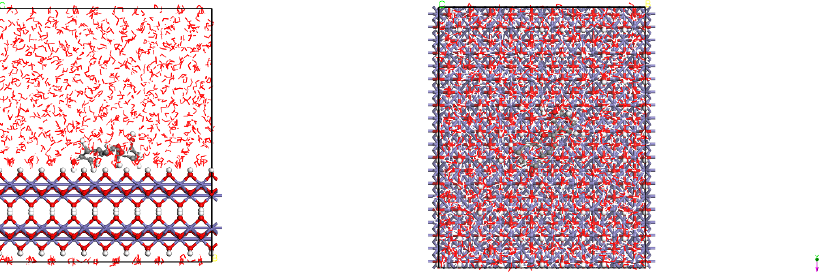
Figure 17. The adsorption configuration of apigenin molecule on γ -FeOOH (010) surface. Figure 18. The adsorption configuration of α -linolenic acid molecule on γ -FeOOH (010) surface. According to the adsorption energies in Table 6, the adsorption energies of three or- ganic molecules on the surface of Fe (110) and γ -FeOOH (010) are all negative, indicating that the adsorption is spontaneous, but the adsorption energies of inhibitor molecules on γ -FeOOH (010) are obviously smaller. On the surface of Fe (110), the adsorption energies of luteolin and apigenin are similar, − 144.175 kJ/mol and − 141.949 kJ/mol, respectively. The adsorption energy of α -linolenic acid is smaller than the former two, only − 133.046 kJ/mol. This is consistent with the law of energy gap value. Combined with the above- mentioned FT-IR and XPS results, the adsorption film mainly composed of luteolin and apigenin was formed on the surface of carbon steel electrode pre-coated in the corrosion inhibitor solution prepared in this paper. The adsorption mechanism is that carbonyl O atoms in luteolin and apigenin hybridize with the 3 d empty orbit of Fe. Table 6. Adsorption energy of corrosion inhibitor molecules. Adsorption Surface